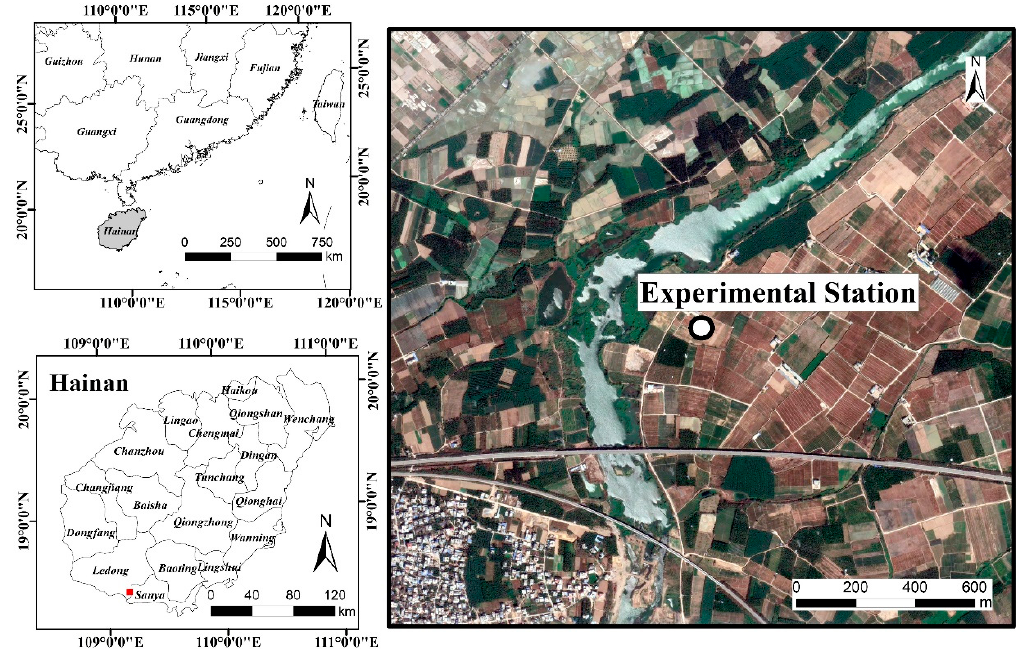
Figure 1. Location of the study site.